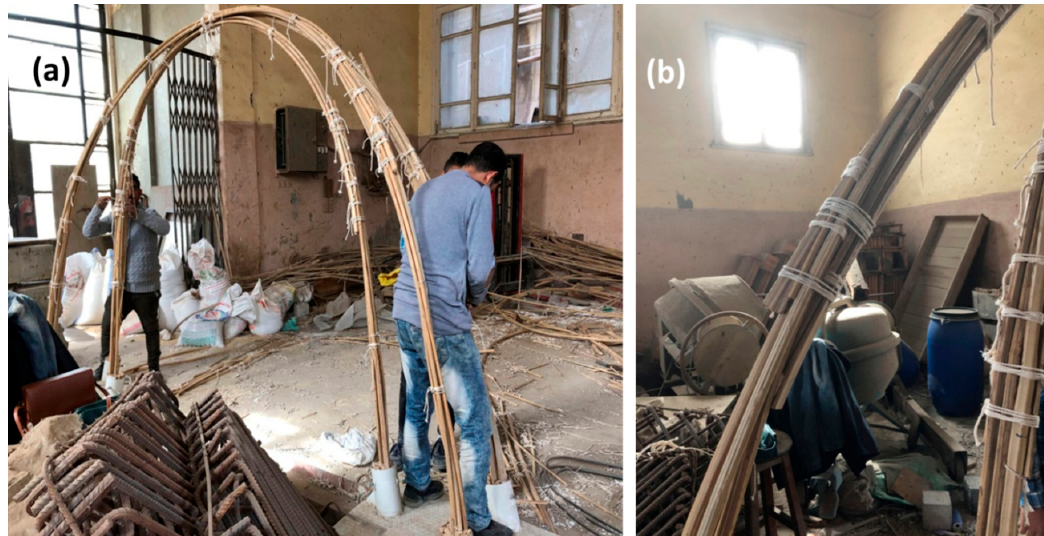
Figure 12. The arches after completion. ( a ) The specimen after the completion of the arches. ( b ) Details of the overlap after the addition of the second half of the middle bundle and fixing it to the bottom bundle.